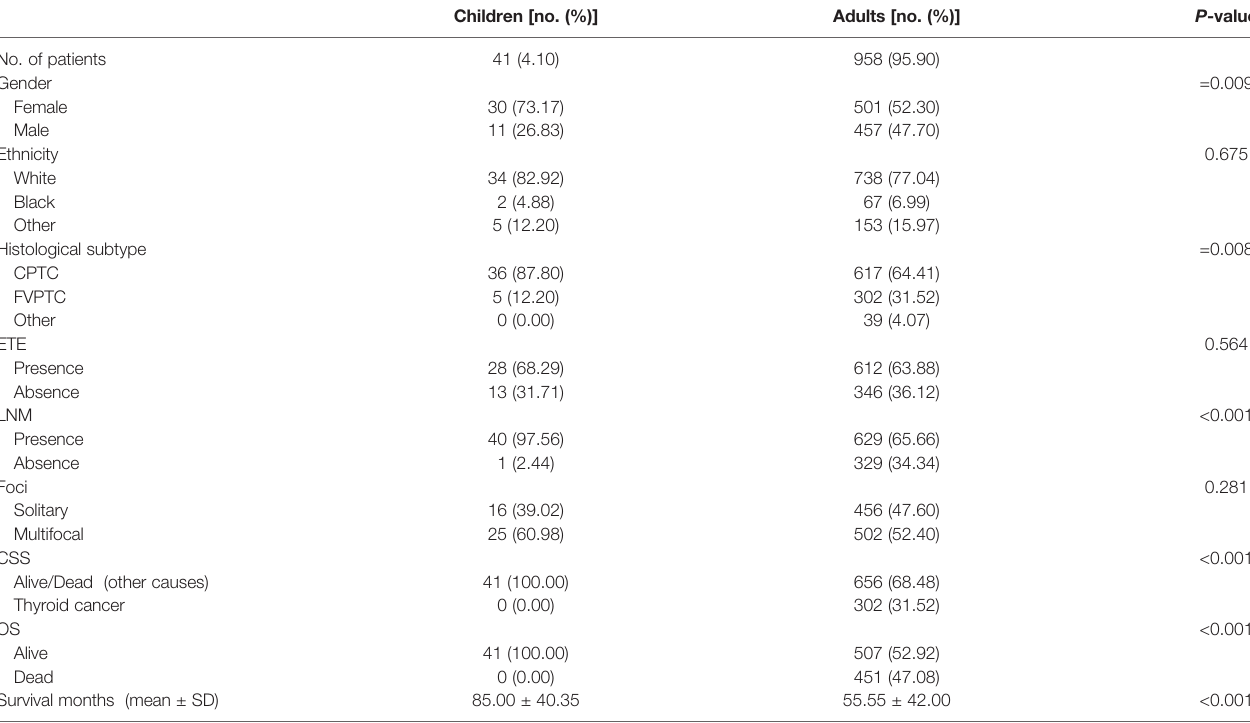
TABLE 2 | Baseline clinicopathological characteristics of PTC patients with distant metastasis. Children [no. (%)] Adults [no. (%)]